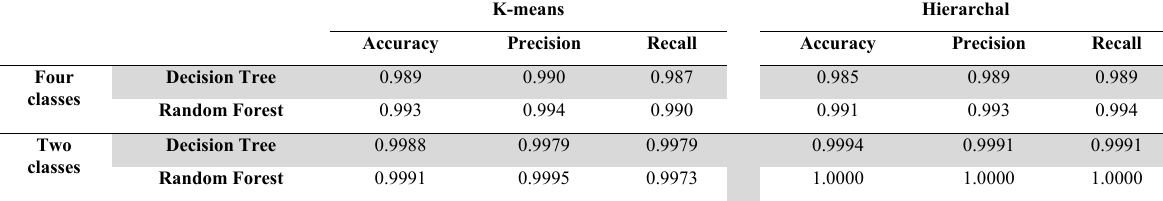
Classification results after the clustering process for all data K-means Hierarchal Accuracy Precision Recall Accuracy Precision Recall